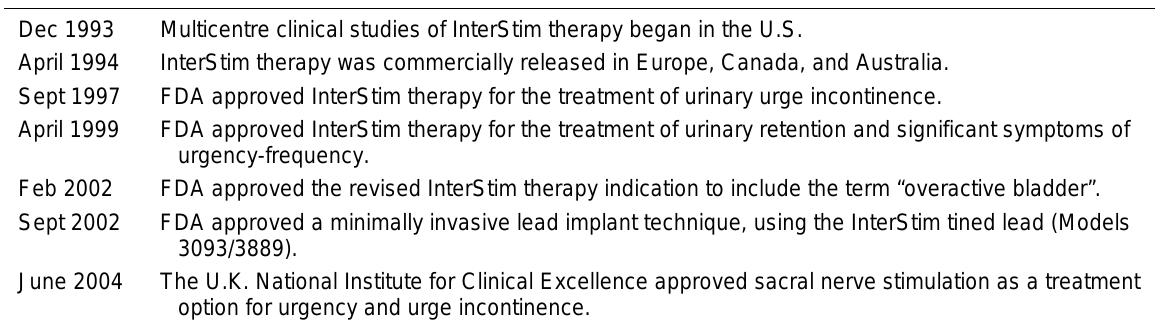
Milestones for InterStim